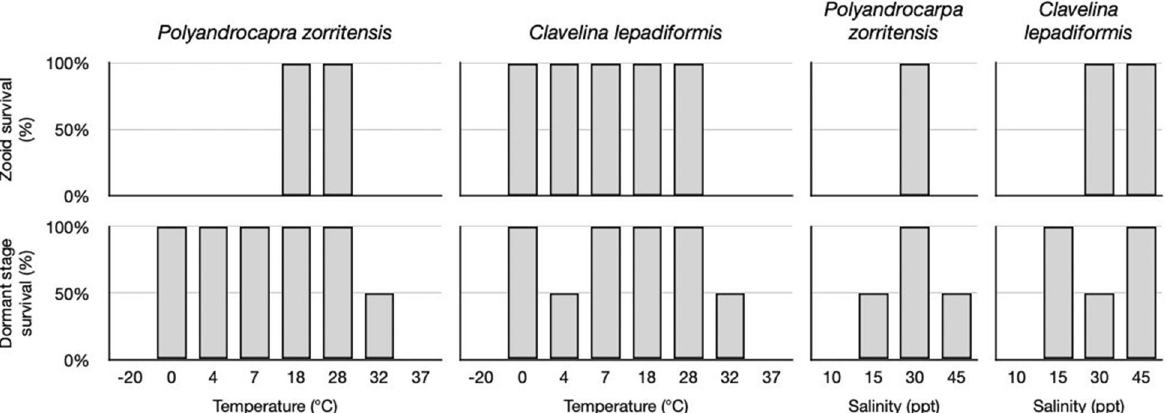
Figure 6. Dormant stages have broader capacity for survival, compared to zooids, in response to environmental stressors. Graphs of percent survival after 48 h exposure to the indicated temperatures and salinity (n = 2 per treatment) for P. zorritensis and C. lepadiformis. Top row shows survival rates of zooids. Bottom row shows survival rates for dormant structures (spherules for Polyandrocarpa zooirtensis and winter buds for Clavelina lepadiformis ).